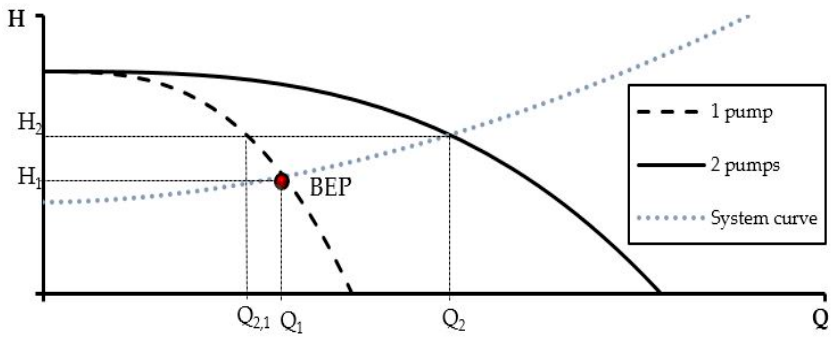
Figure 2. Representation of a single and parallel pump curves.